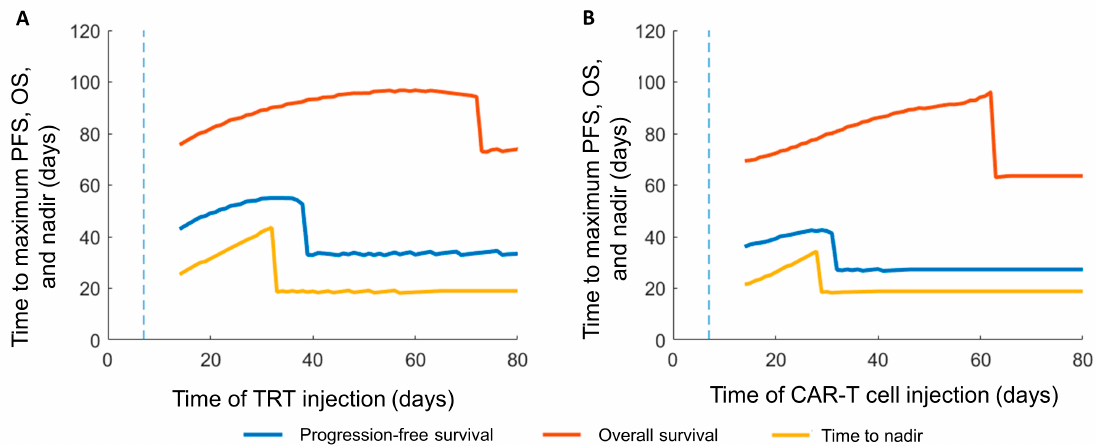
Figure 4. Simulated response to combination TRT and CAR-T cell therapies. Progression-free survival (PFS), overall survival (OS), and time to nadir for two treatment sequences: ( A ) CAR-T cells on day t = 7 (vertical dashed line) followed by TRT starting from t = 14–80. A clear maximum benefit is seen in PFS, OS, and time to nadir. ( B ) TRT on day t = 7 (vertical dashed line) followed by CAR-T starting from t = 14–80. The time to maximum OS, PFS, and nadir is measured from when the tumor is initiated at t = 0.